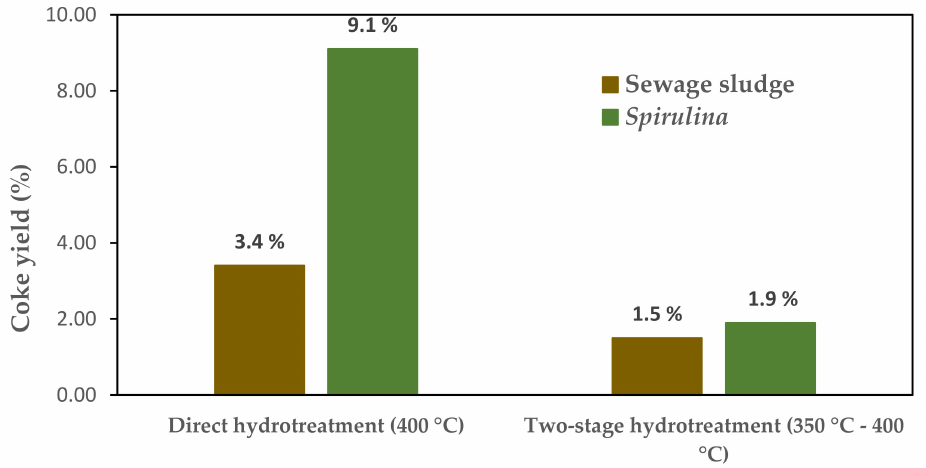
Figure 4. Comparison of coke yeld obtained after direct hydrotreating at 400 ◦ C and two-stage hydrotreating. Reproduced from reference